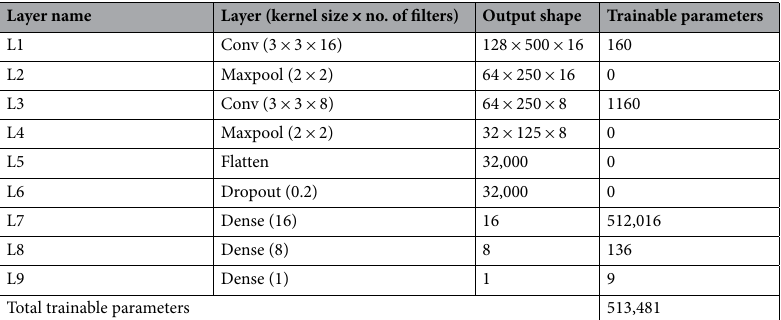
Table 2. Summary of CNN architecture for